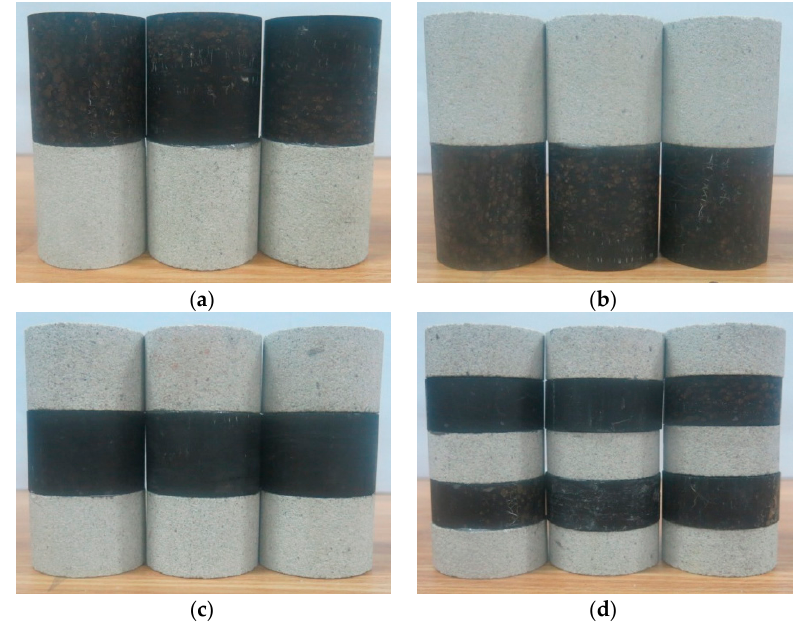
Figure 3. Experimental sandwiched coal-rock specimen. ( a ) C-R; ( b ) R-C; ( c ) R-C-R; ( d )